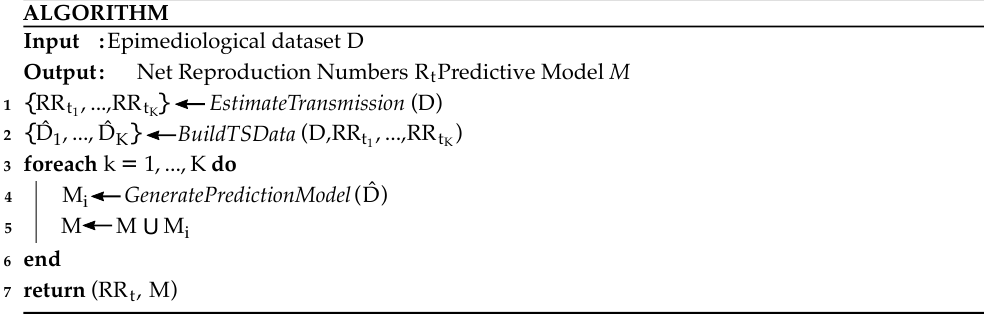
Figure 2. Workflow of the predictive modeling